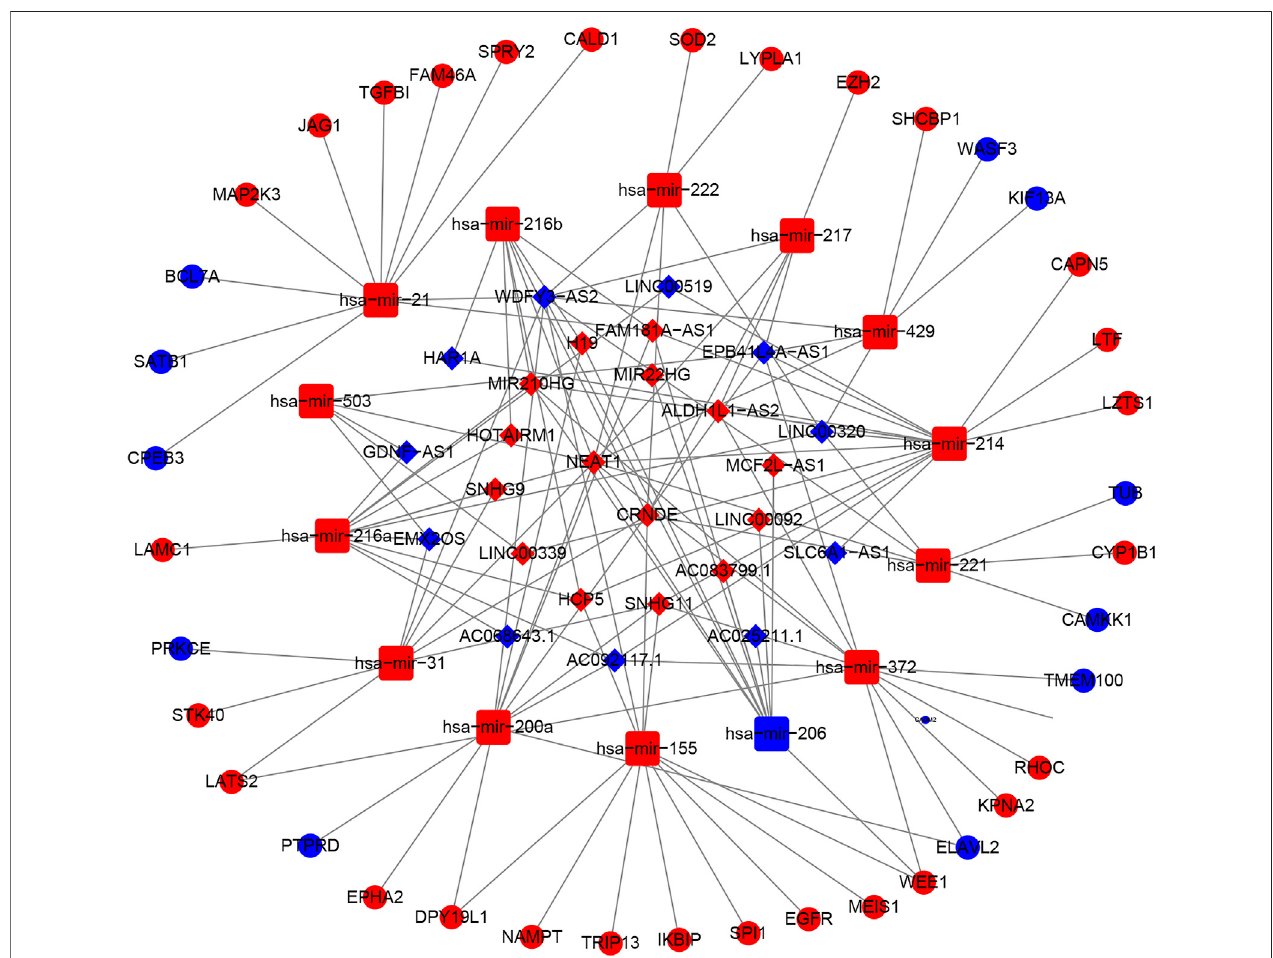
FIGURE 8 | The ceRNA network based on risk groups in TCGA dataset (red: up-regulation. blue: down-regulation).